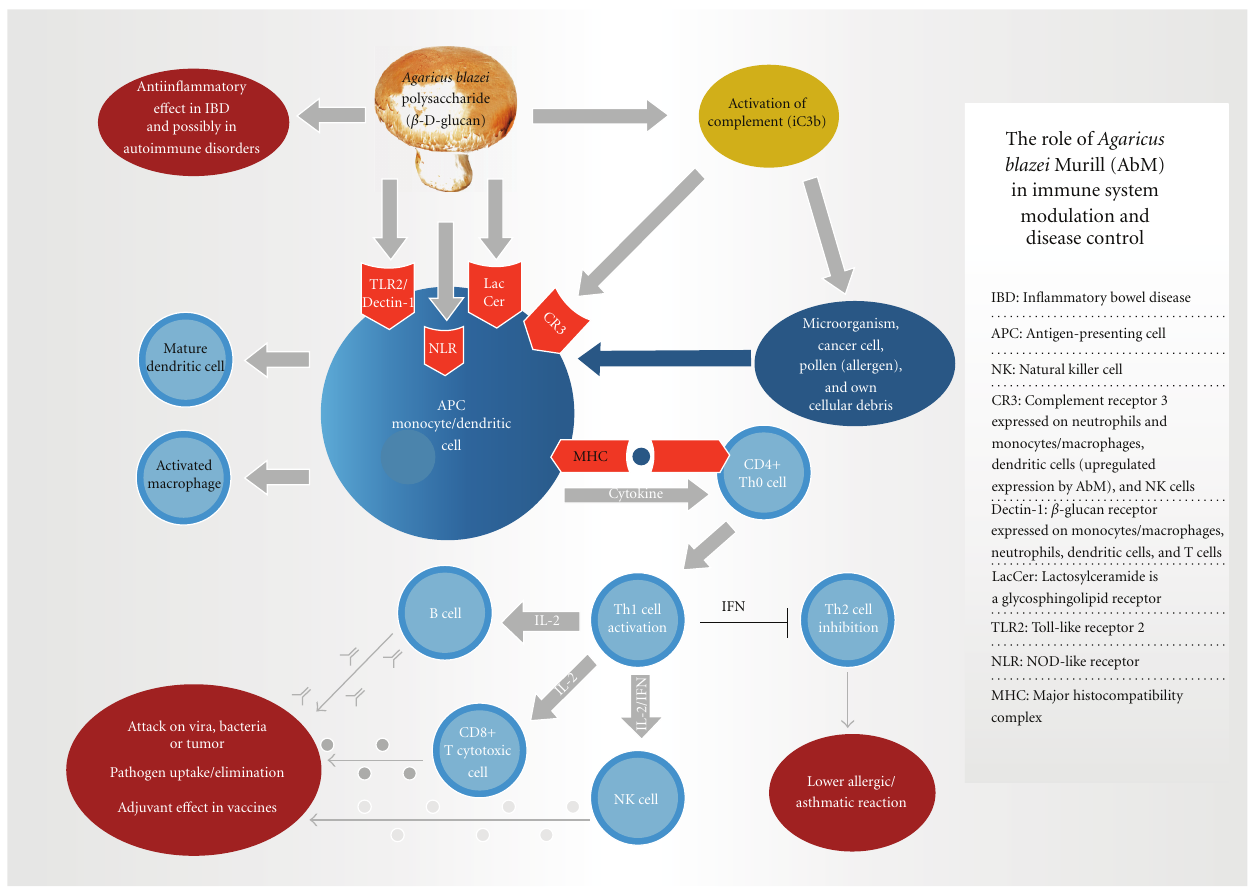
Figure 5: Role of the mushroom Agaricus blazei Murill in immune system modulation and disease control. It is assumed that besides β - glucans also other, yet unknown substances in the mushroom, probably of low molecular weight, do parttake in the action. IL-12 is the cytokine from the monocyte/dendritic cell that stimulates